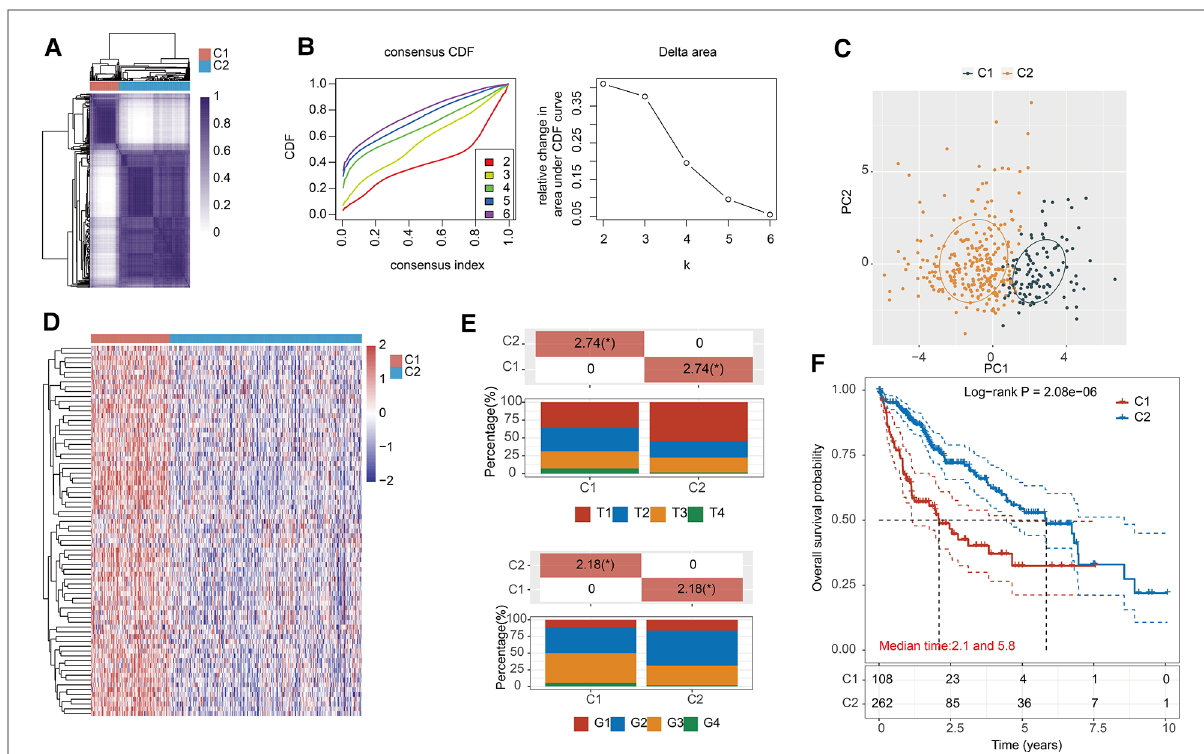
FIGURE 2 Identi fi cation of MRPs associated subtypes in HCC. ( A ) The consensus matrix analysis classi fi ed two clusters, cluster 1 ( n =108), cluster 2 ( n =263). ( B ) Consensus clustering cumulative distribution function (CDF) and relevant variations in the area under the CDF curve. ( C ) PCA revealed the distribution of patients in two classi fi ers. ( D ) The heatmap signi fi ed the levels of MRPs in two subtypes. ( E ) The bar chart presented the clinicopathological differences in the two clusters. ( F ) KM curve veri fi ed the OS difference in MRPs